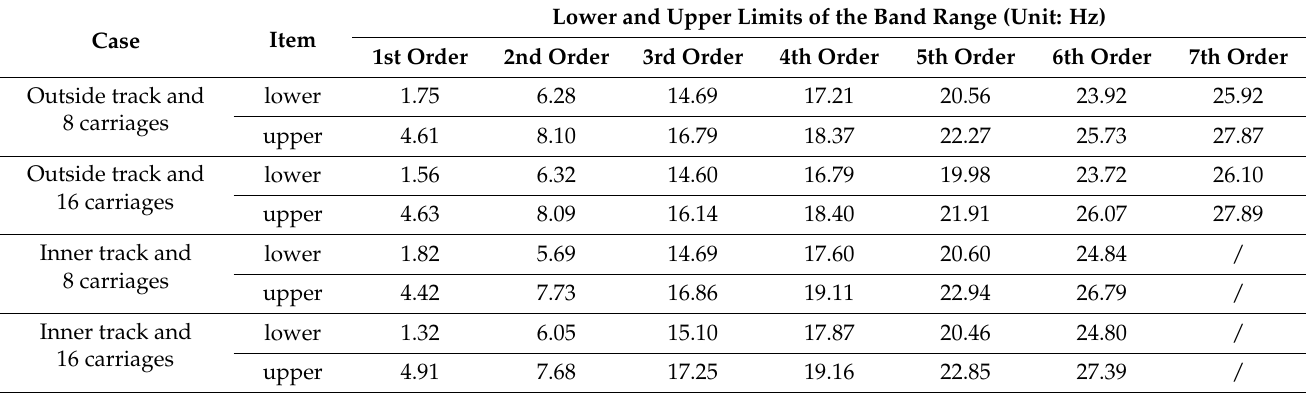
Table 4. Band range estimation for the main orders of the frequency of train-induced forced